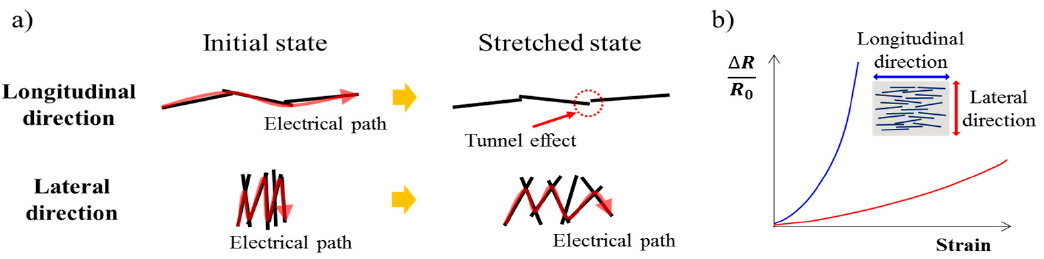
Figure 1. Working principle of the proposed strain sensor. ( a ) Working principle of the longitudinally and laterally aligned strain sensors. ( b ) Graph for predicting the resistance change rate according to the strain of the fabricated strain sensors.